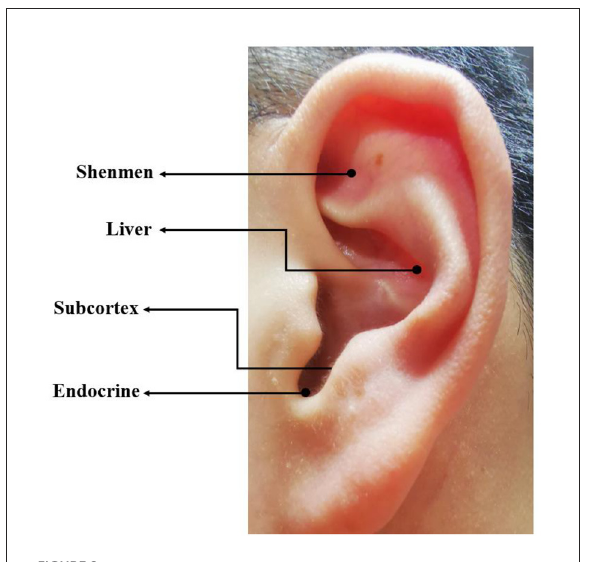
FIGURE2 Auricular points selected in the auricular acupressure group.